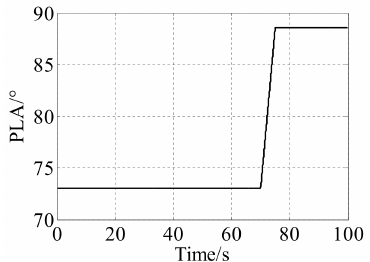
Figure 22. Throttle rod